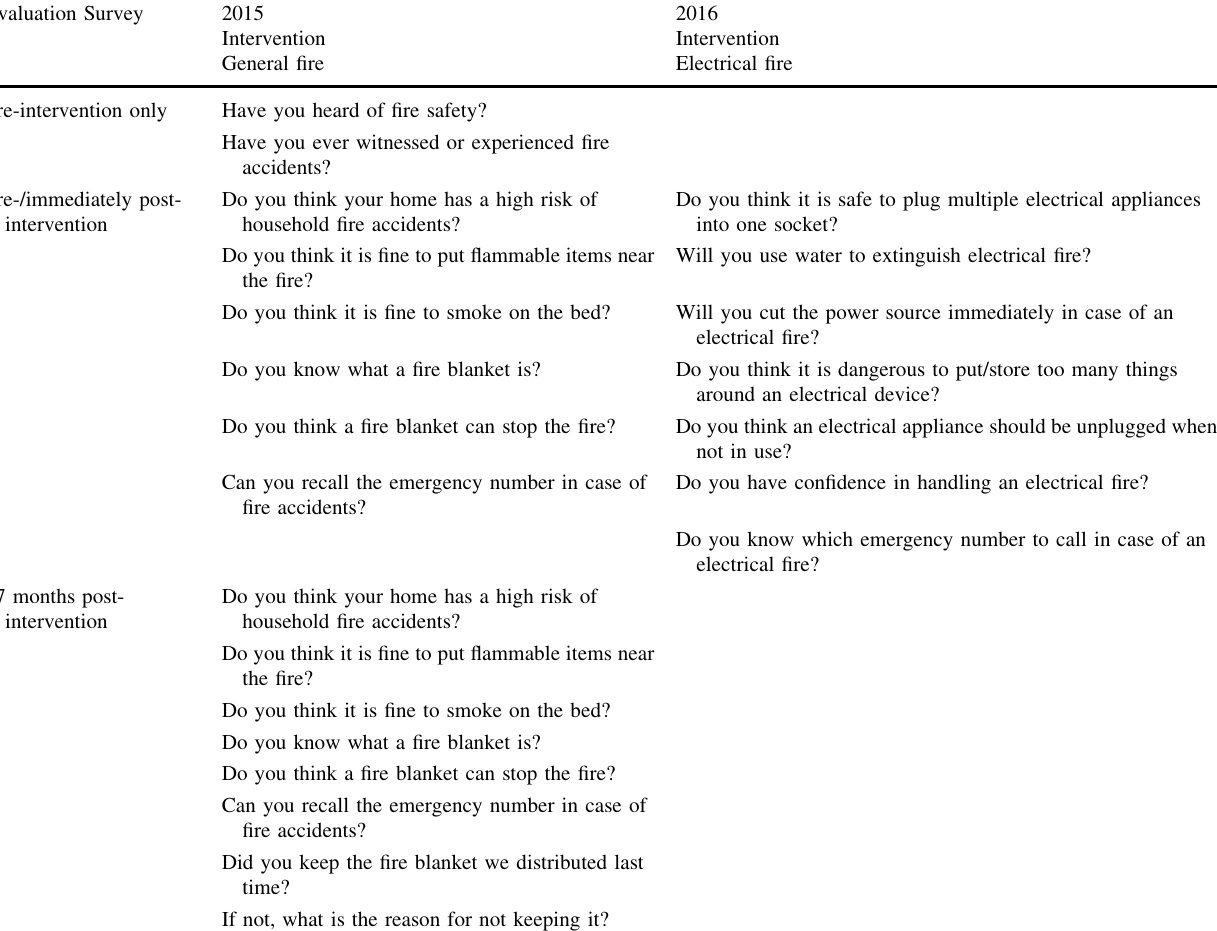
Table 1 Questions in the evaluation surveys for the 2015 fire risk education intervention (pre-/immediately post-/17 months post-intervention) and the 2016 intervention (pre-/immediately post-intervention) in Nanjiang Village, Guizhou Province, China Evaluation